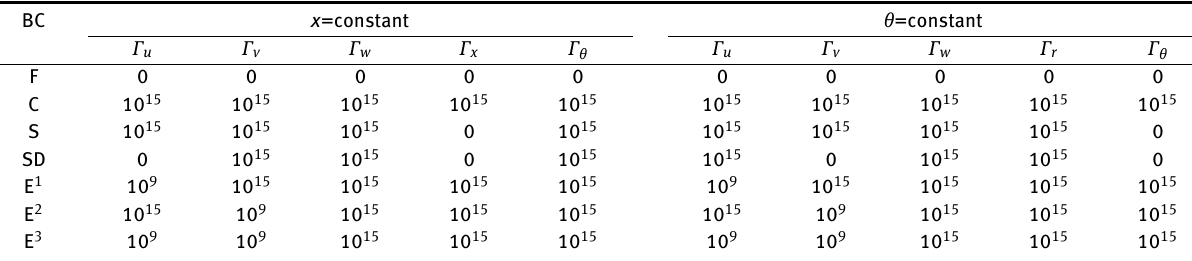
Table 1: The corresponding elastic restraint parameters for various boundary conditions.